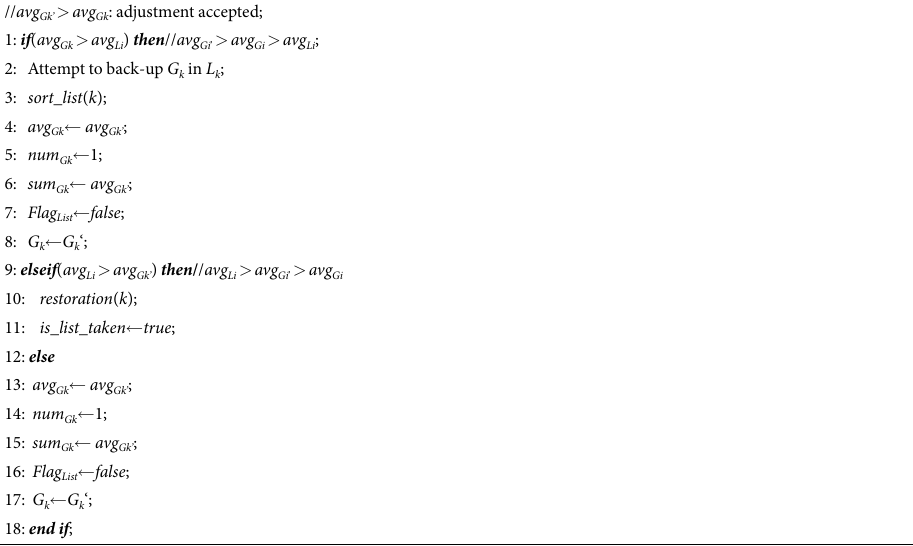
Algorithm 5: Operation when edge switching adjustment is accepted